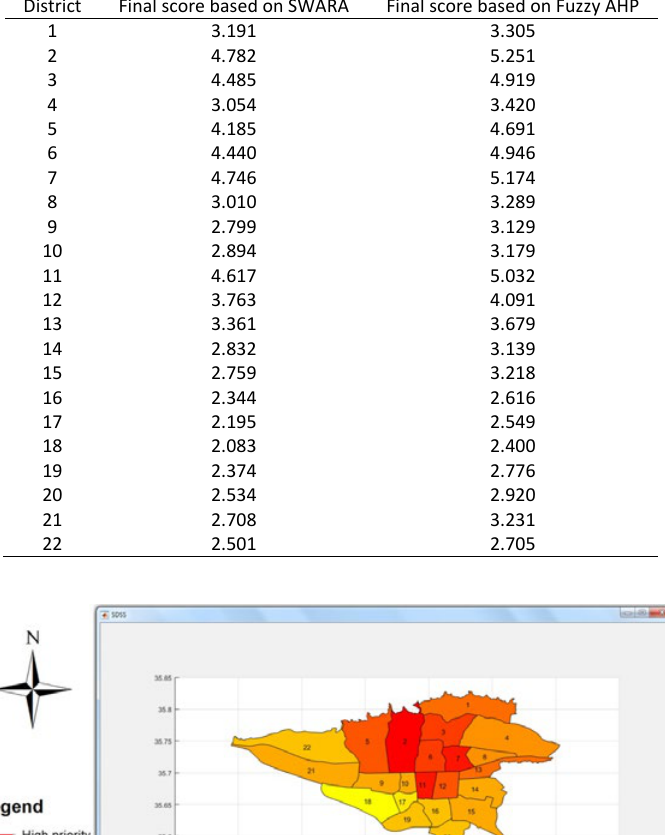
Table 6: Final score of each district